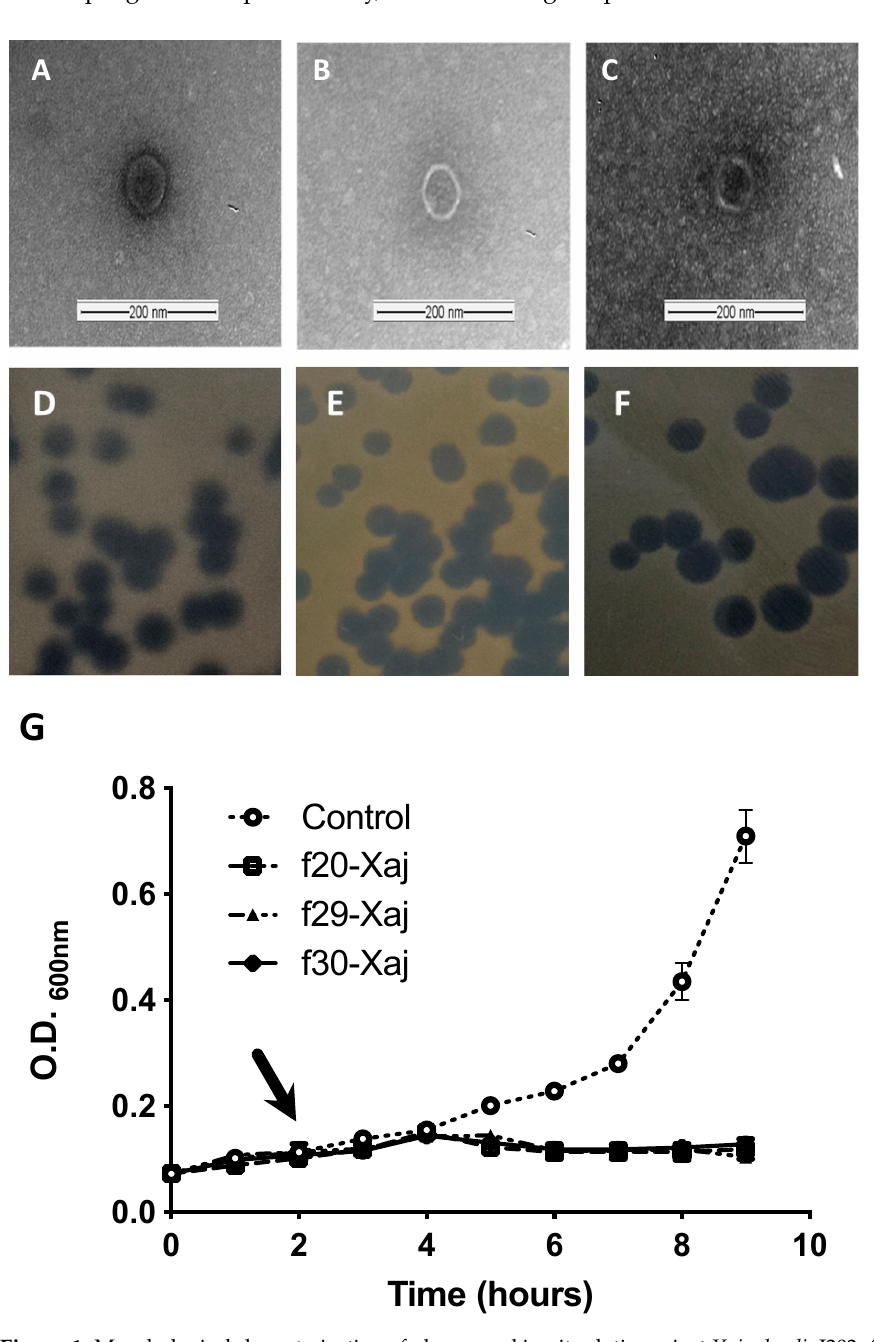
Figure 1. Morphological characterization of phages and in vitro lytic against X. juglandis J303. ( A – C ): MET, ( D – F ) Lysis plaque, ( G ) Delay curve. Arrow indicates the time of addition of individual bacteriophage. All experiments were employed in three independent replicates.